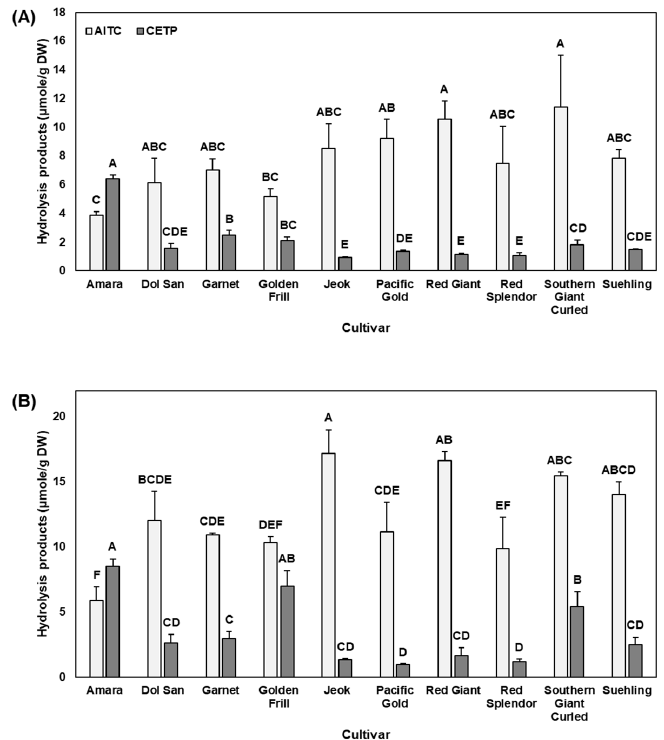
Figure 2. AITC and CETP concentration of 11 mustard leaves at ( A ) baby leaf and ( B ) mature stages. Error bars indicate the standard error of the total hydrolysis product concentration ( n = 3). Different letters above the error bars indicate significant difference in each hydrolysis product concentration among cultivars at each physiological stage by Tukey’s honest significant difference (HSD) at p ≤ 0.05.